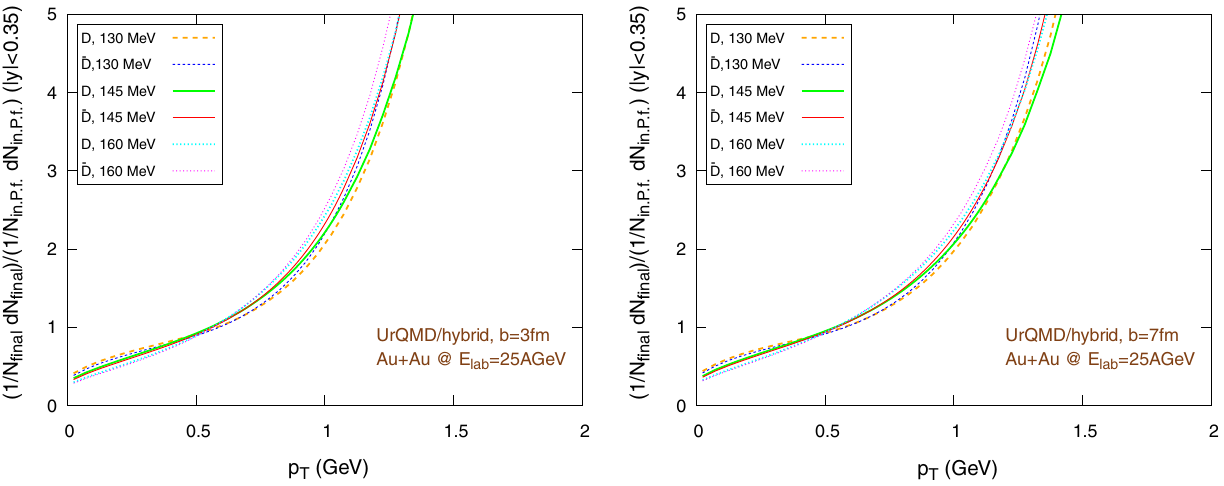
= 25AGeV, using the lab